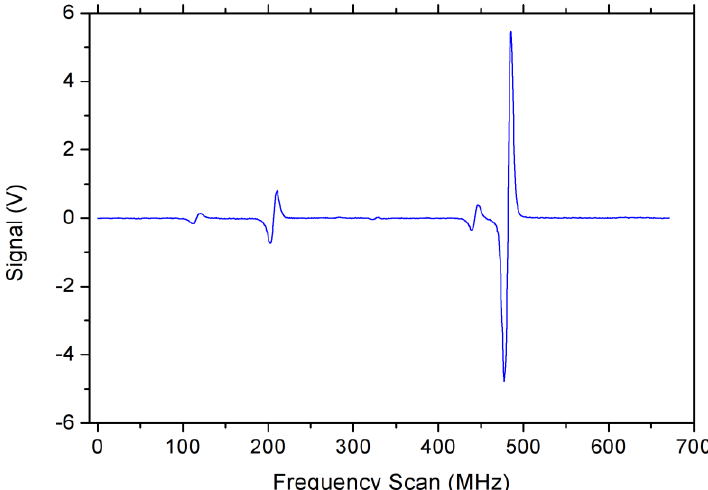
. The measured width of the pp